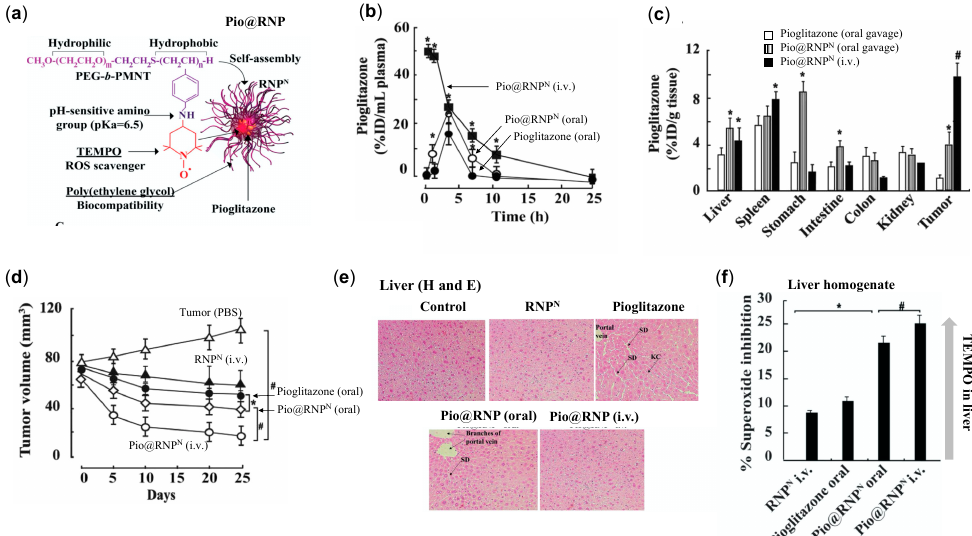
Figure 8. RNP increases the chemotherapeutic efficiency of pioglitazone (Pio) and suppresses its adverse effects. ( a ) Chemical structure of RNP N ’s polymer (PEG-b-PMNT) and illustration of pioglitazone encapsulated in RNP N . ( b ) Systemic bioavailability pioglitazone (oral), Pio@RNP N (oral), and Pio@ RNP N (i.v.) in mice administered with 15 mg/kg of pioglitazone. ( c ) Biodistribution of pioglitazone in various organs of mice after the treatment period of 25 days. ( d ) Tumor growth profile of prostate cancer (PC-3) in a mouse model, administered with PBS (control), free pioglitazone and Pio@ RNP N (Pio: 15 mg/kg and RNP N : 300 mg/kg). ( e ) RNP N suppresses the adverse effect exerted by pioglitazone as assessed by liver histology stained by H and E (SD: sinusoidal dilatation, KC: Kupffer cells). ( f ) Superoxide inhibitory activity in liver homogenates administered with samples (from tumor xenograft studies) as evaluated by xanthine-xanthine oxidase assay [116]. * p < 0.05 was considered significant. This figure is reproduced with permission from reference [116]. Copyright 2016, Elsevier Ltd.